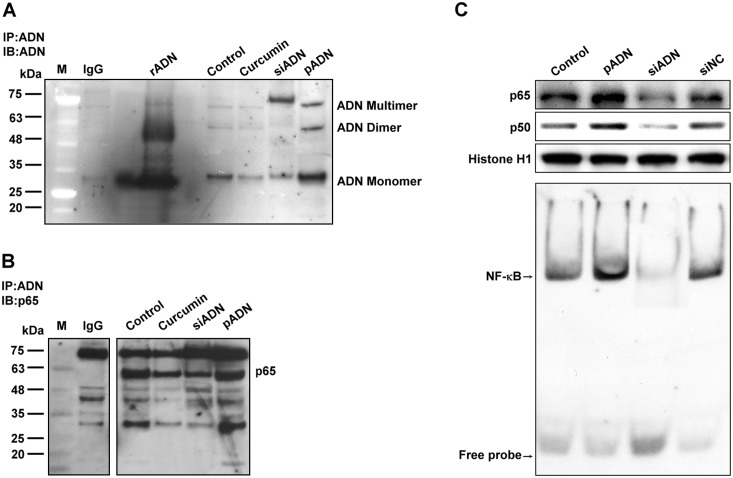
Co-immunoprecipitation assay of adiponectin interaction with p65.
(A) A549 cells treated with curcumin, silenced, or transfected with adiponectin were lysed and adiponectin was co-immunoprecipitated using adiponectin antibody. Immunoblotting with the indicated antibodies confirmed the co-precipitation of adiponectin monomer, dimer, and multimer. (B) Co-immunoprecipitation was performed using anti-adiponectin and anti-p65 antibodies. The p65 elute was separated on SDS-PAGE and immunoblotted with the corresponding antibodies, which showed substantial association of adiponectin with the p65 component. (C) Activation of NF-κB by overexpression or silencing of adiponectin was determined by EMSA. Adiponectin increased the nuclear translocation of p65/p50 and NF-κB activation, but silencing adiponectin expression had the opposite effect.